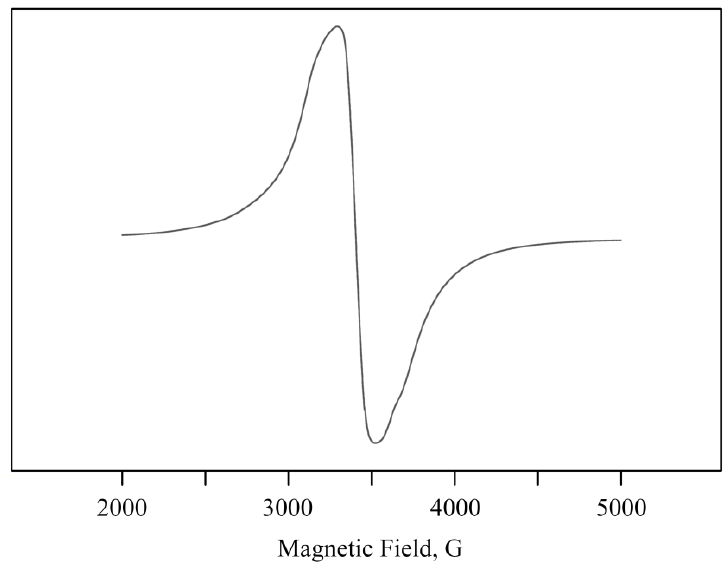
Figure 6. Typical EPR spectrum of Mn-containing NCs for κ -CG-Mn.